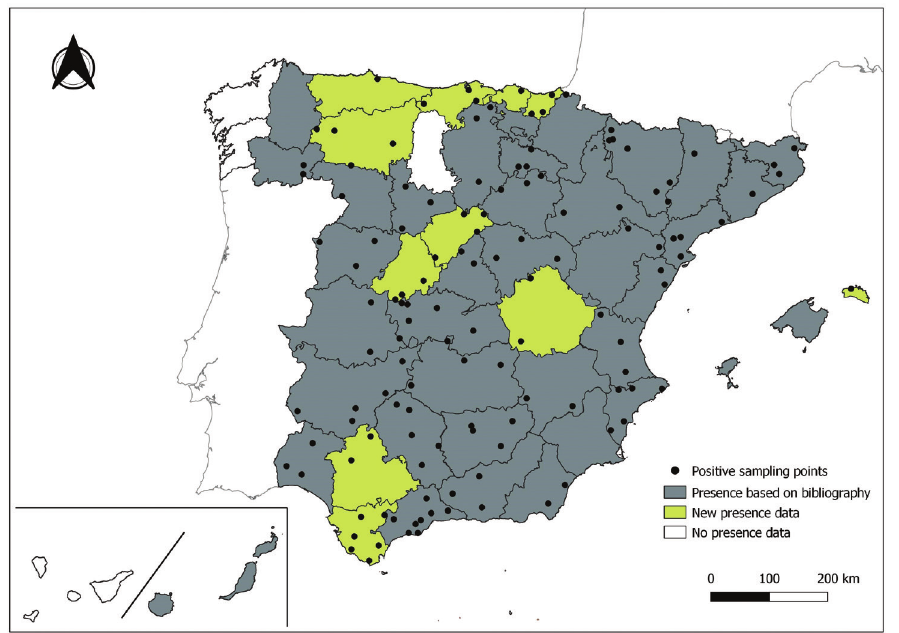
Figure 2. Distribution of Phlebotomus ariasi in Spain.